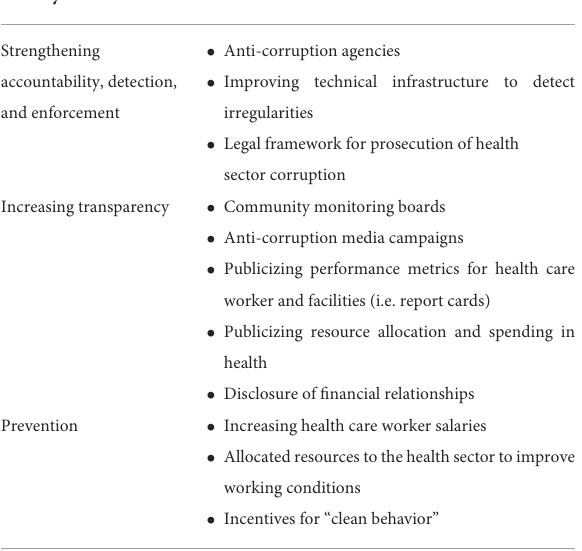
TABLE 2 Examples anti-corruption theories and corresponding